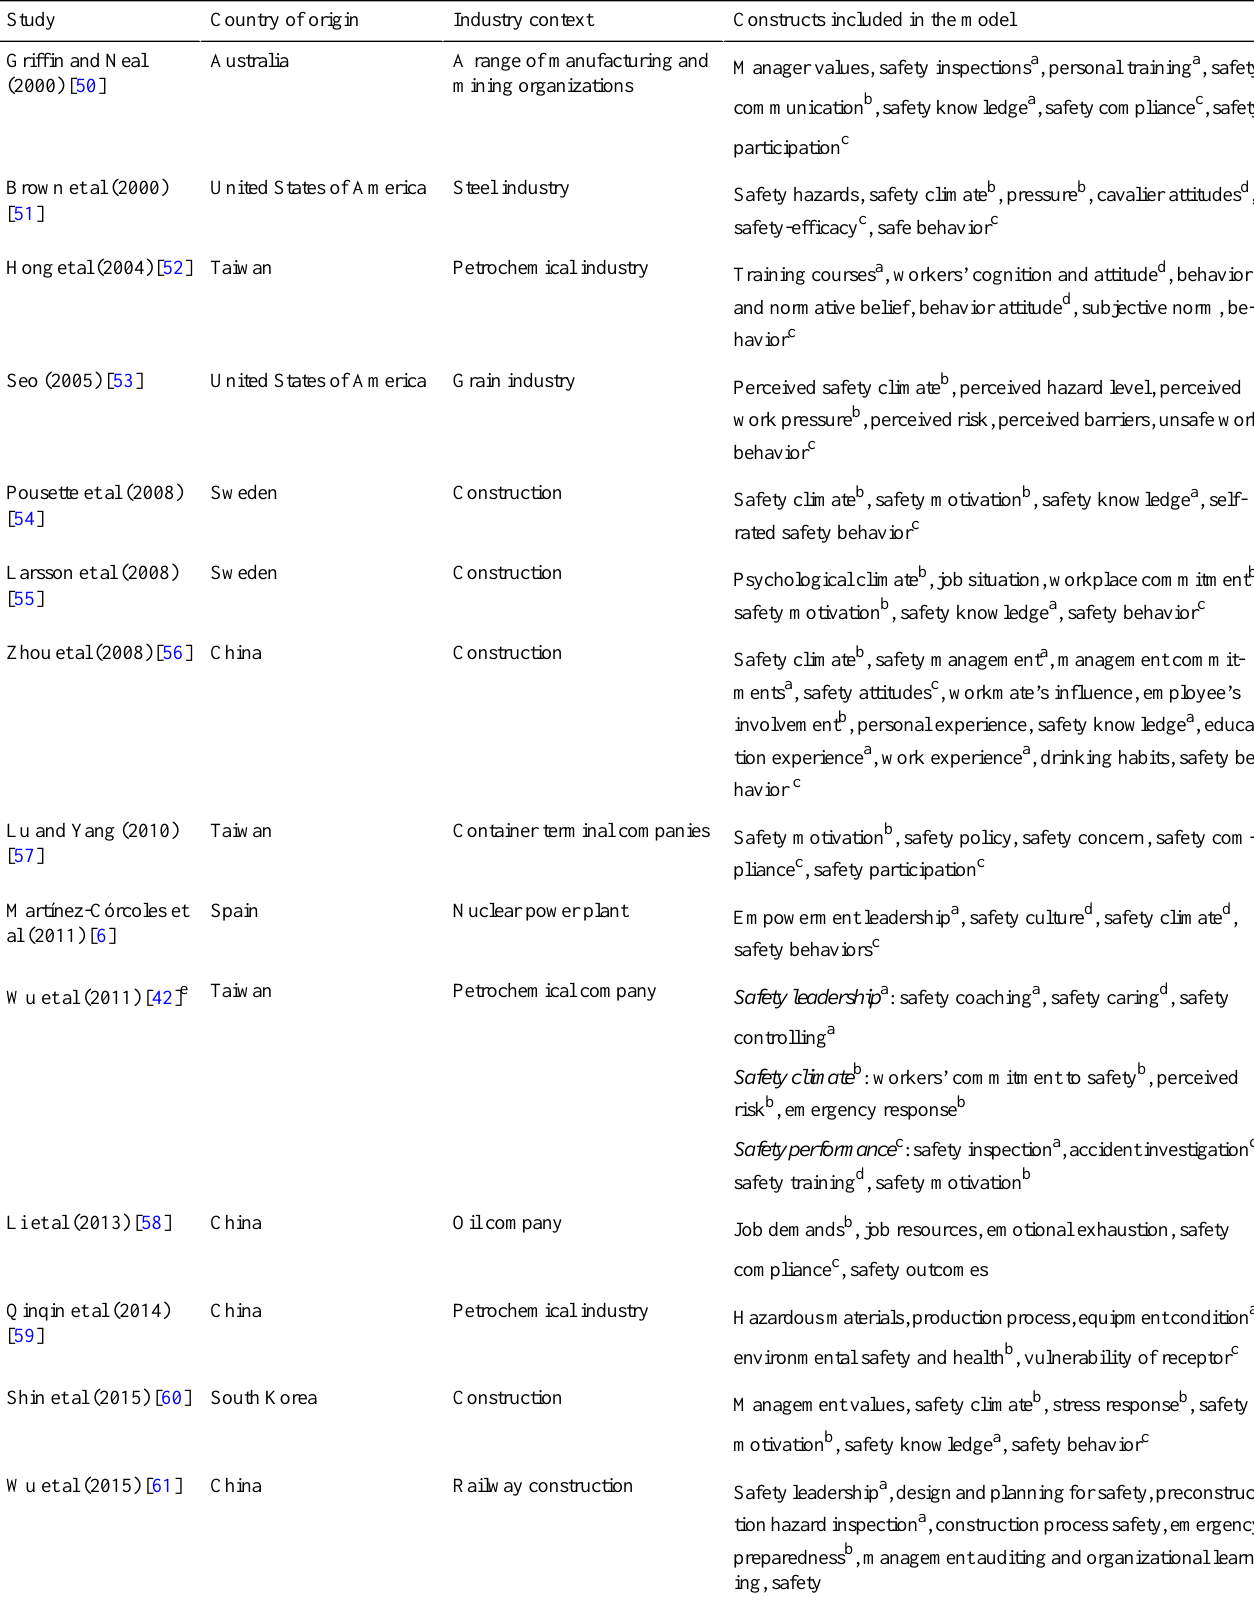
Table 1. Description of the included studies (listed by the year of publication) and the constructs used in each of